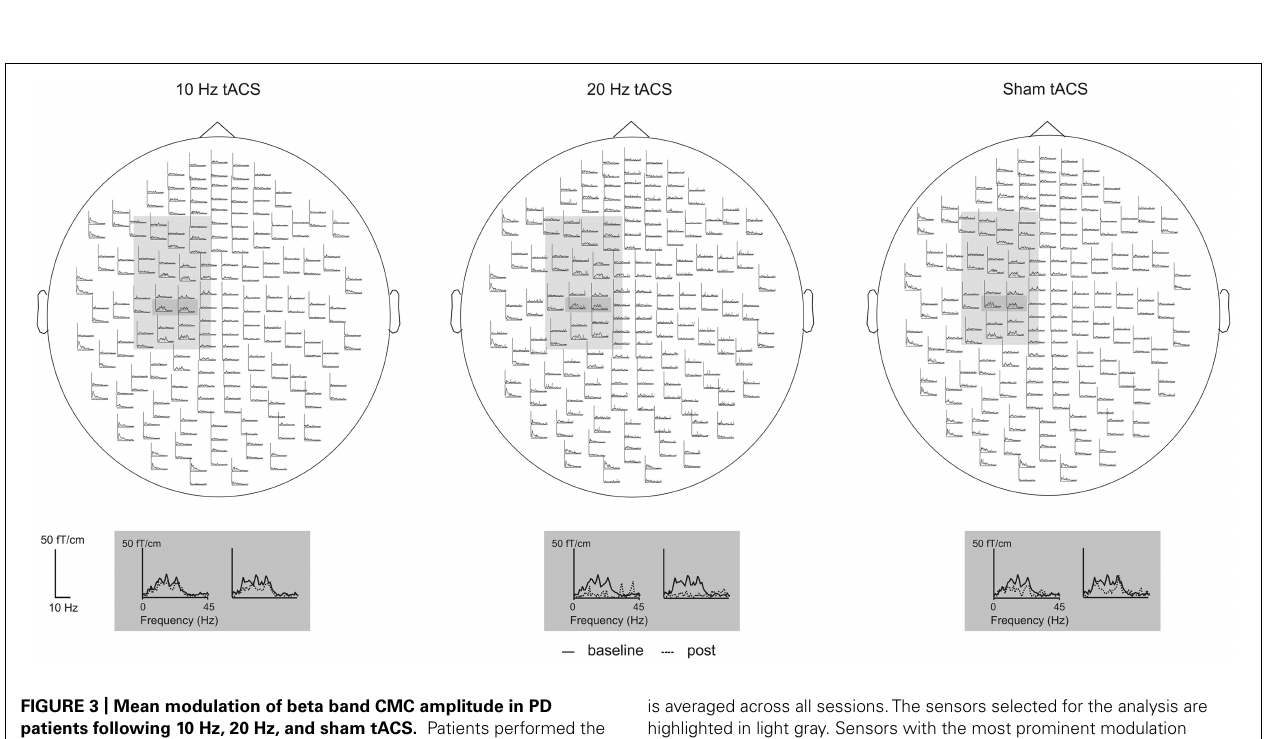
FIGURE 2 | Beta band cortico-muscular coupling (CMC) during isometric contraction. (A) Most distinct beta band CMC peaks between S1/M1 sensors and contralateral EDC muscle before and after 20 Hz tACS in one representative patient (left panel) and control subject (right panel). (B) One representative MEG sensor plot